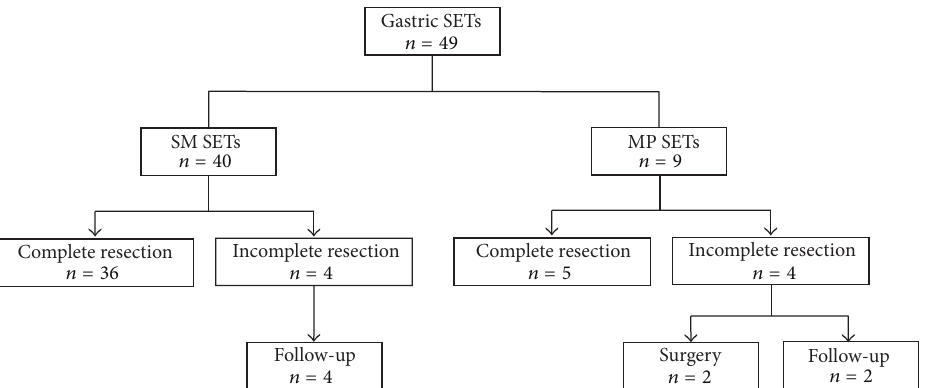
Figure 1: Flowchart of patients included in the study. SETs: subepithelial tumors; SM: submucosa; MP: muscularis